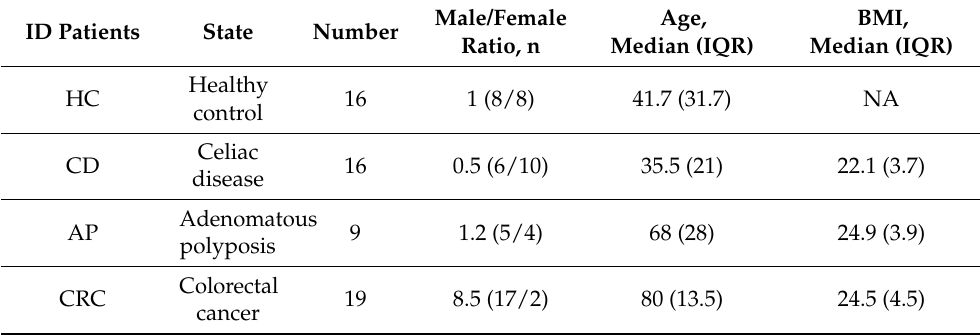
Table 1. Features of enrolled patients. BMI = body mass index; IQR = interquartile range. HC = healthy controls; CD = celiac disease; AP = adenomatous polyposis; CRC = colorectal